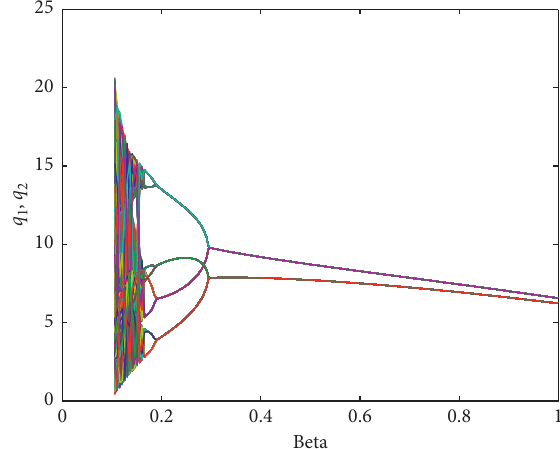
Figure 8: Bifurcation diagram for game (12) as a function of control parameter β when k � 0 .